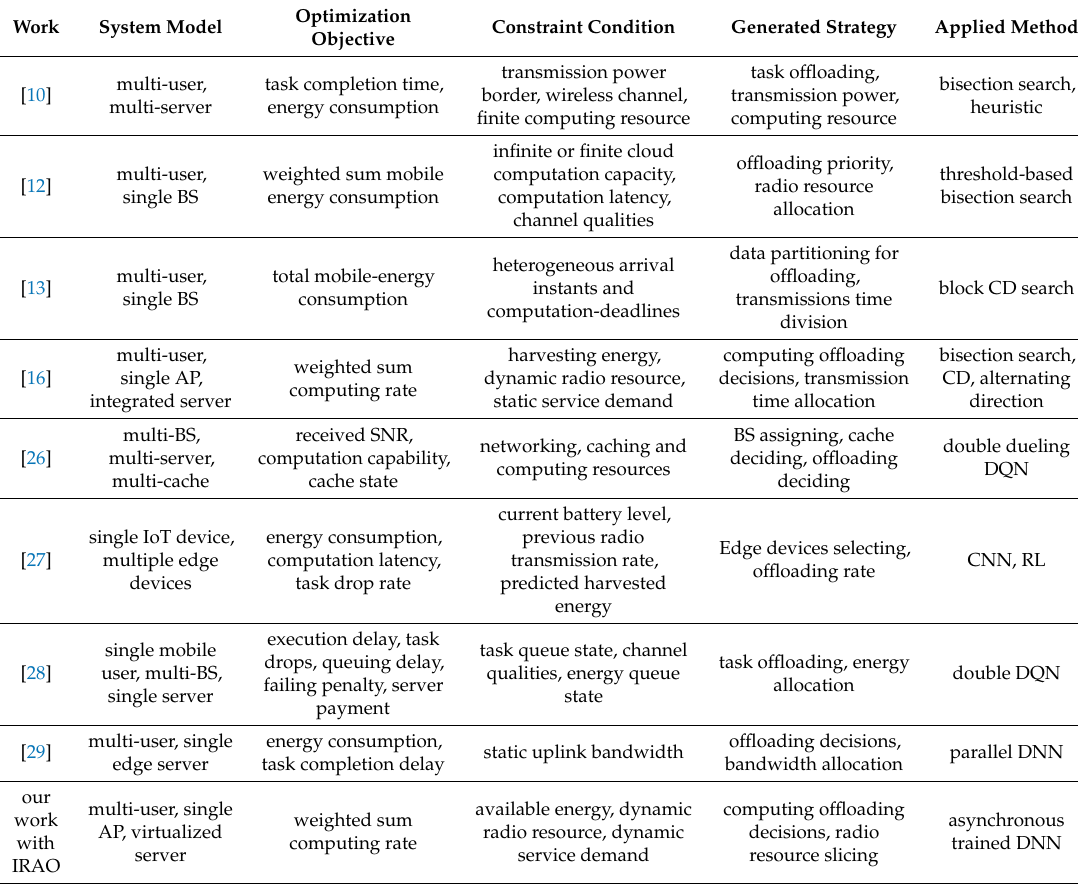
Table 1. The comparisons of related works and our